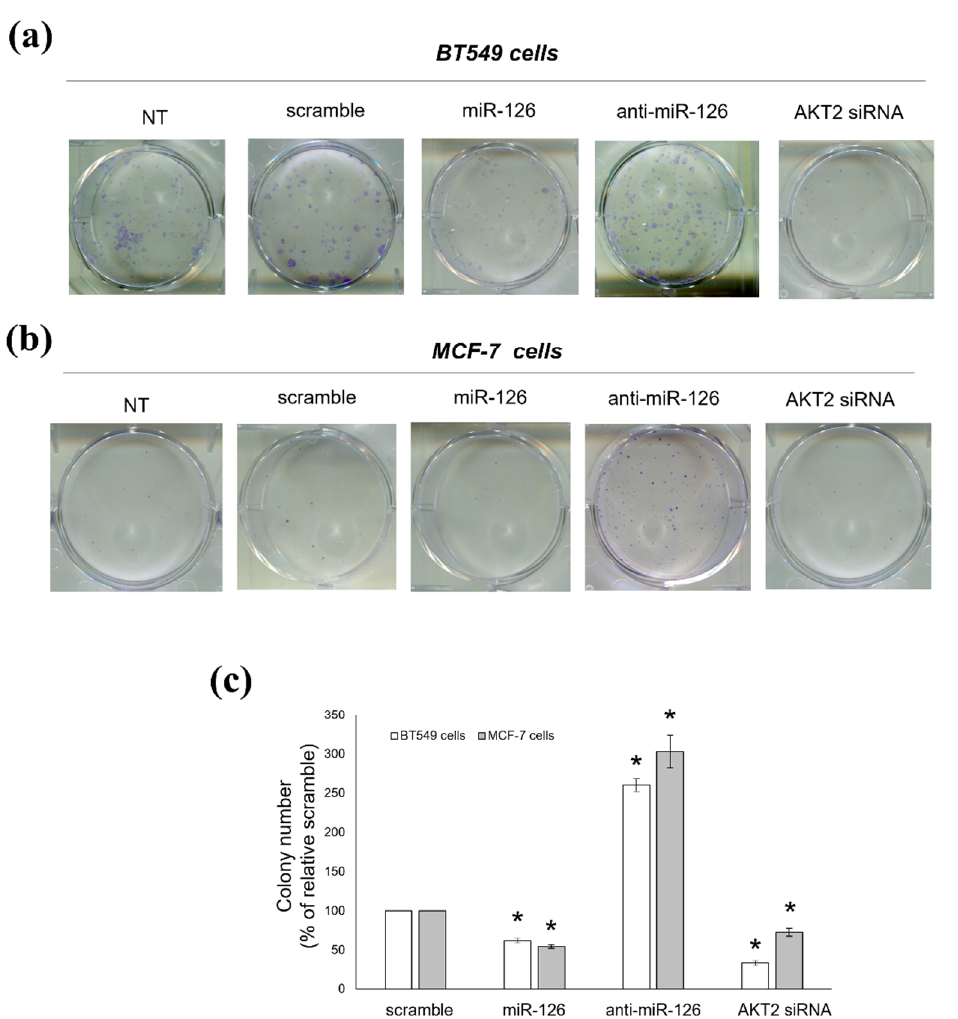
Figure 5. miR-126-3p/AKT2 axis reduces the clonogenic potential of BC cells. Colony forming unit (CFU) assay performed with BT549 ( a ) and MCF-7 ( b ) cells left untreated (NT) or transiently transfected with either scramble oligo (scramble), miR-126-3p-mimic (miR-126), miR-126-3p-inhibitor (anti-miR-126), or AKT2 siRNA. Photographs are representative of three independent experiments. ( c ) Histograms show the colony number reported as percentage of scramble-transfected cells (not statistically differing from NT cells), arbitrarily set to 100% (absolute colony number = 94.67 ± 2.21 and 33.12 ± 0.18 for BT549 and MCF-7 cells, respectively). Data are shown as mean ± SEM. *: p < 0.01 versus relative scramble.